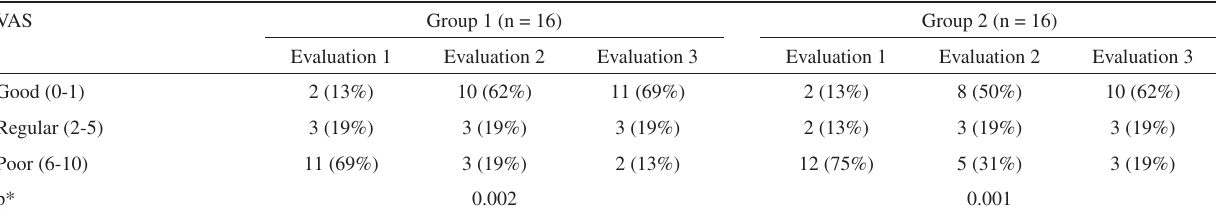
Table 4 – Patient distribution according to intensity of gait pain on visual analog scale (VAS) in Groups 1 and 2 before and after treatment